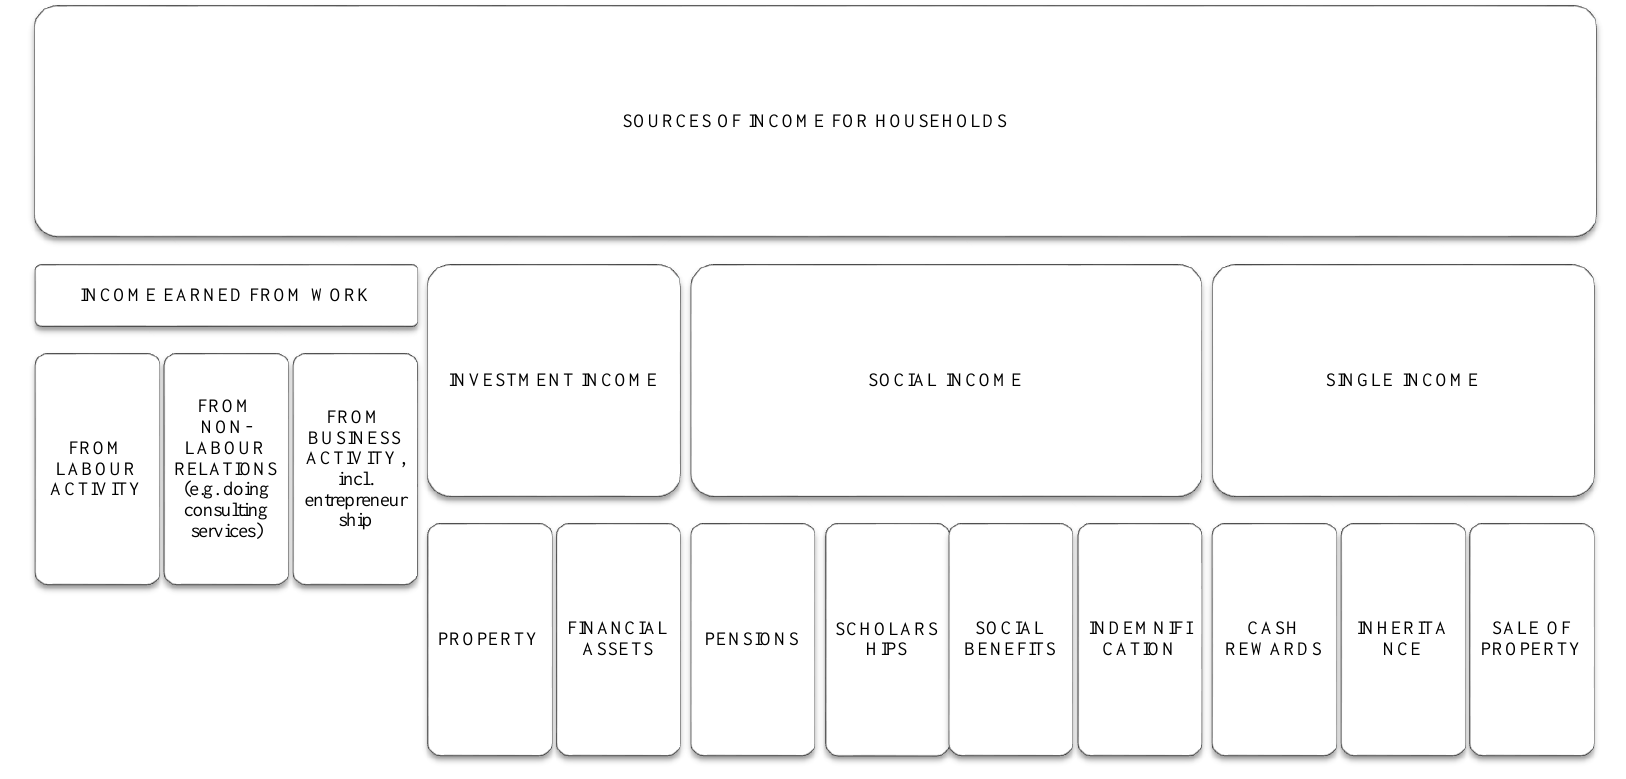
Fig. 1. Sources of income for